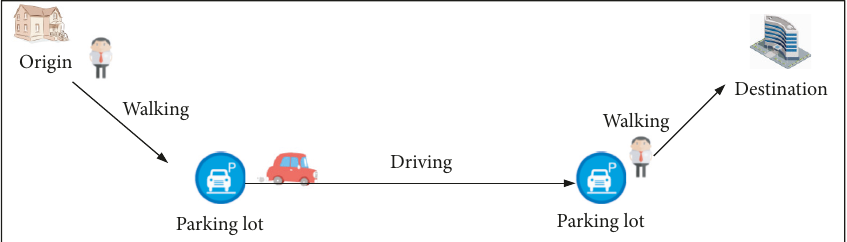
Figure 1: Illustration of a vehicle driving